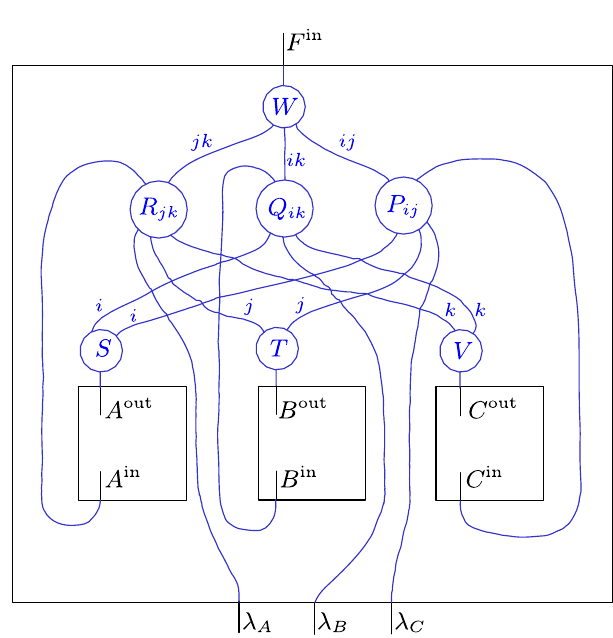
Fig. 10 Extended circuit diagram decomposition of the BW unitary extension of the AF process. Compared to Fig. 9 the wires for A in , B in and C in are bent around (as well as some swaps inserted for better